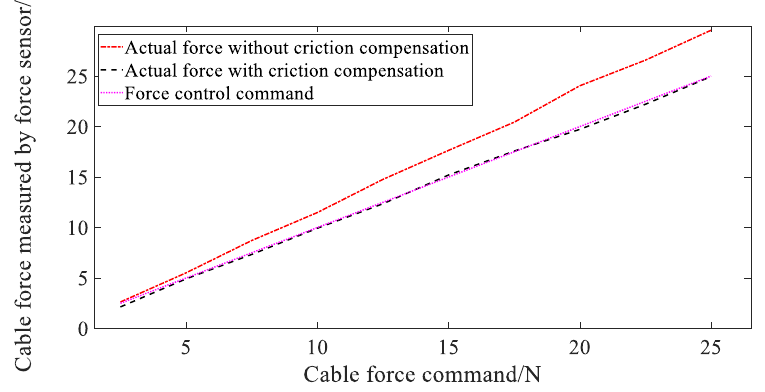
Figure 9. Comparison of NSECA control effect based on friction compensation.